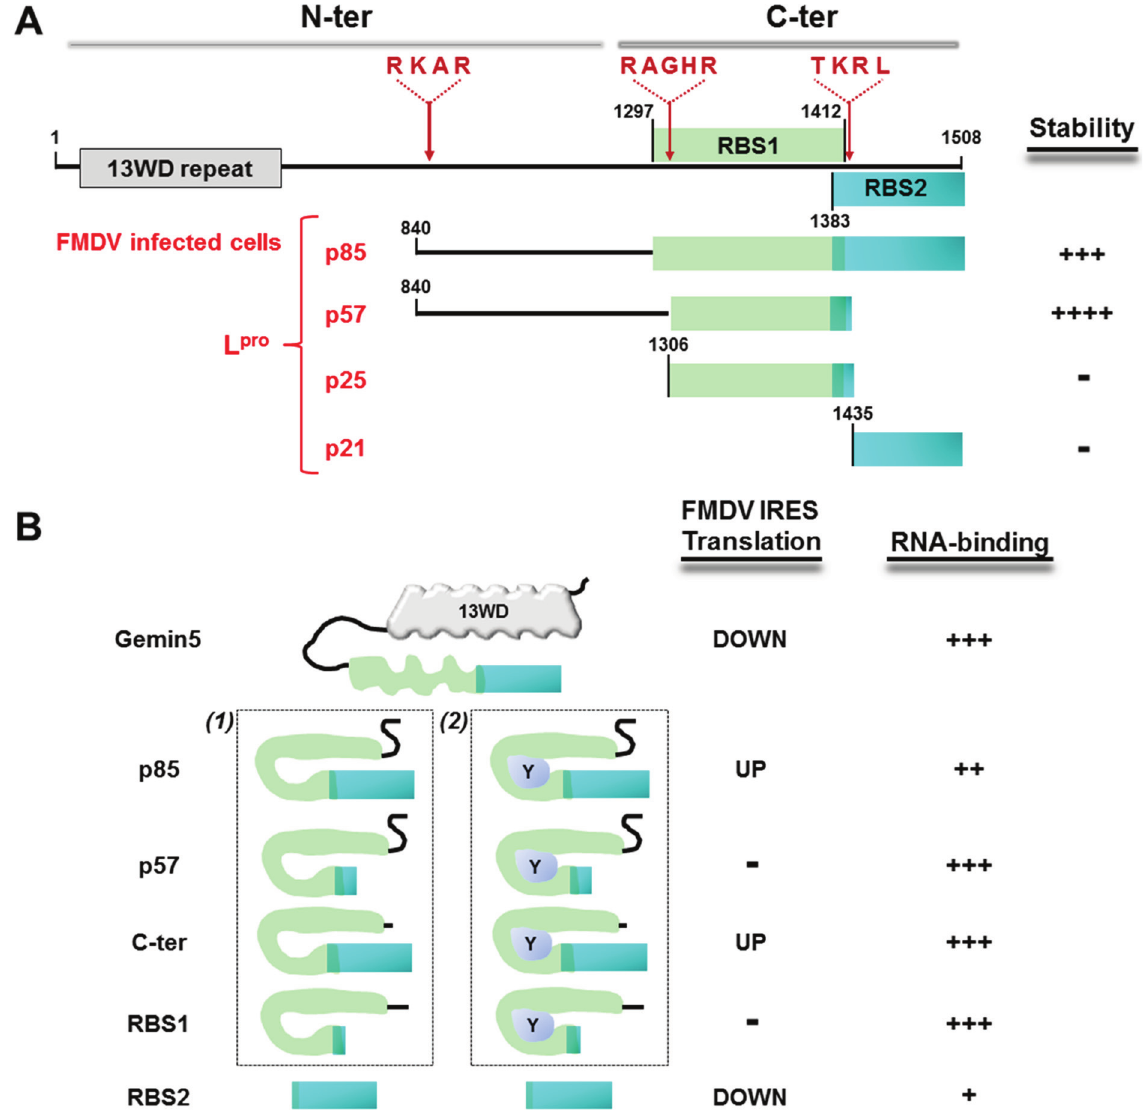
Figure 4. ( A ) Schematic representation of Gemin5 cleavage products observed during viral infection. N-ter and C-ter indicates amino-terminal and carboxi-terminal regions, respectively. The sequences recognised by L pr °, RKAR, RAGHR and TKRL are indicated. ++++ depicts the higher stability of p57, compared to p85; +++ indicates undetected in infected cells. ( B ) Hypothetical model of the role of Gemin5 in IRES-dependent translation. (1) and (2) represent two alternative mechanisms possibly occurring in infected cells. Y (blue oval) indicates an unknown cellular factor possibly interacting with the proteolytic products. The capacity to regulate translation is indicated by on/off and the intensity of the IRES interaction by +, ++ or